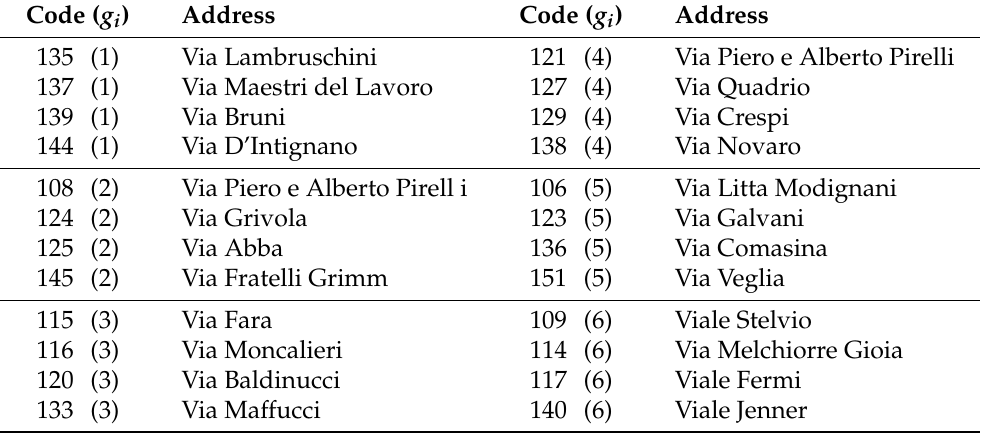
Table 2. Location of the 24 Dynamap noise monitoring stations (cf.Figure 6). For each sensor, the code number, group index g i (within parenthesis), and name of the street are reported